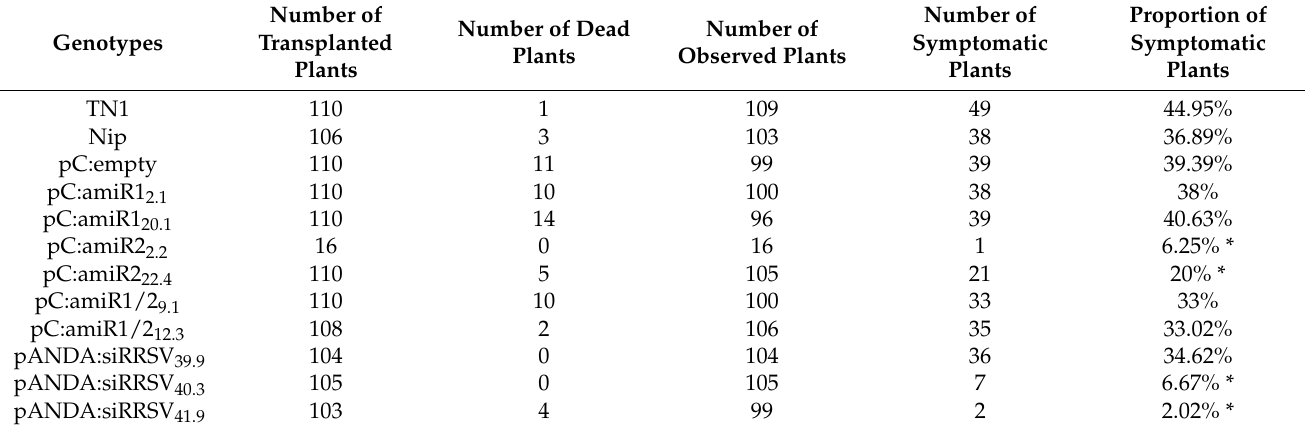
Table 1. Infectivity assay of amiR and siRRSV transgenic plants challenged with RRSV viruliferous BPH.